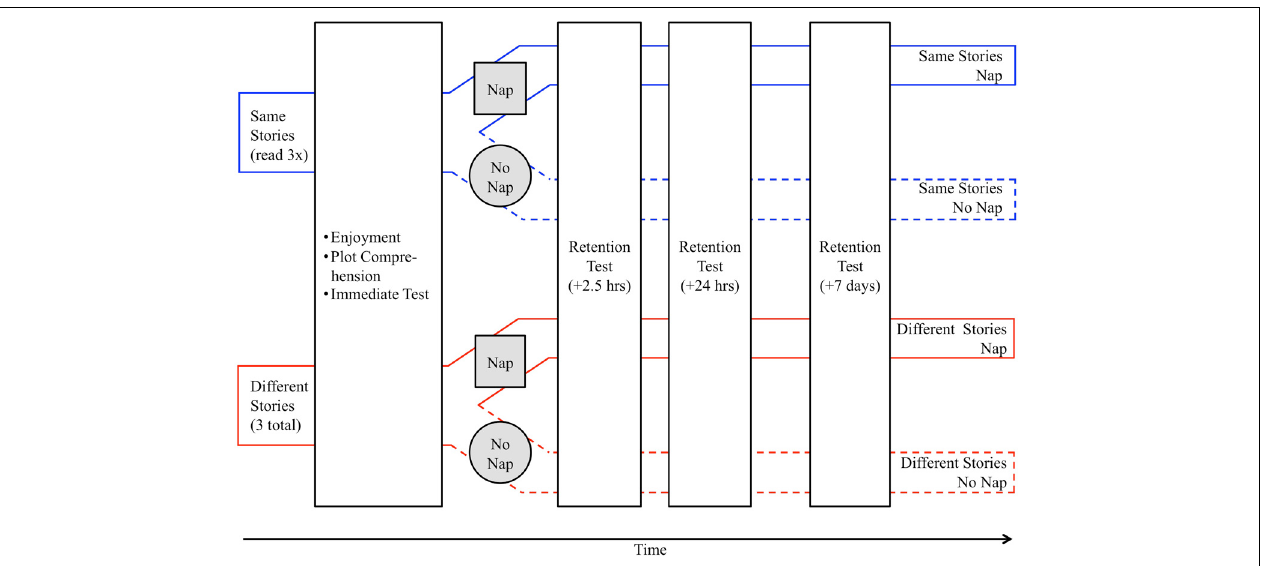
FIGURE 1 | Schematic representation of the experimental design. Children participated in one of four conditions (same story nap, same story no nap, different stories nap, different stories no nap). Children’s word recall